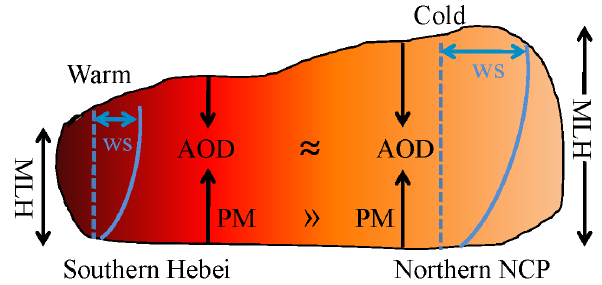
Figure 10. The schematic diagram of the meteorological causes for heavy haze in southern